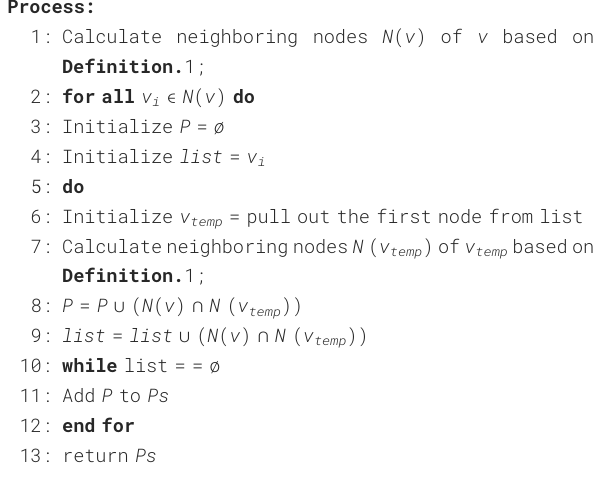
Algorithm 1. Potential communities exploration.